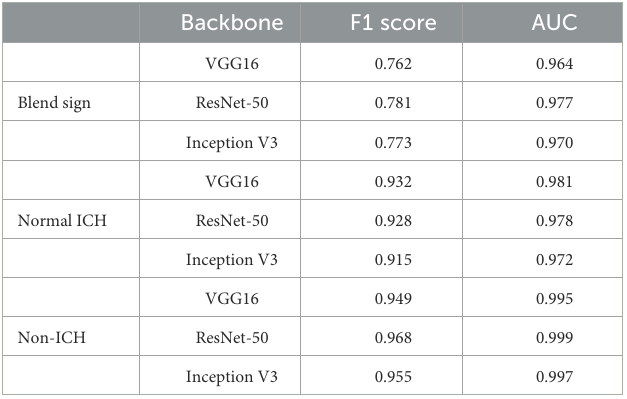
TABLE 4 Performance of the automated detection algorithm with different pre-trained